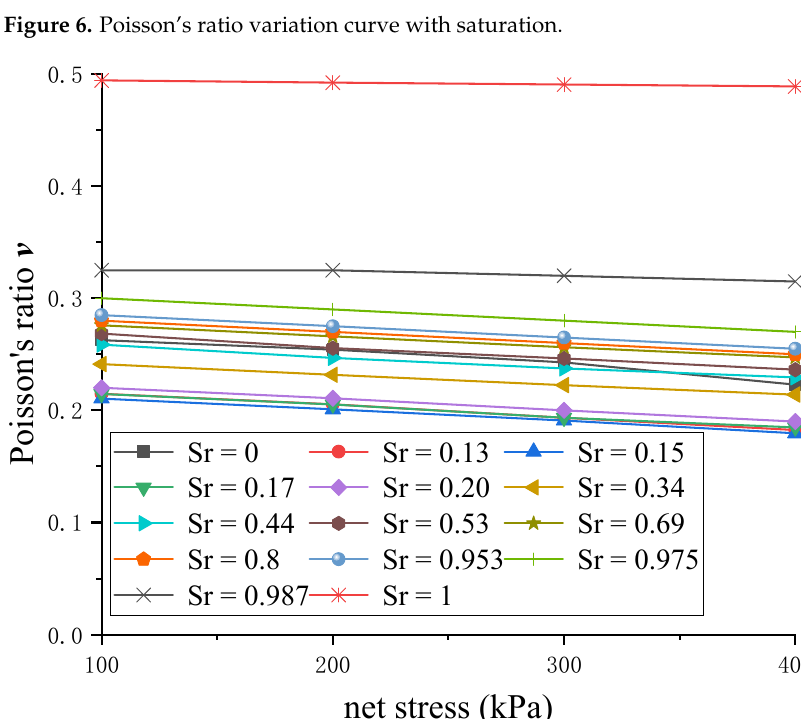
Figure 7. Poisson’s ratio variation curve with net